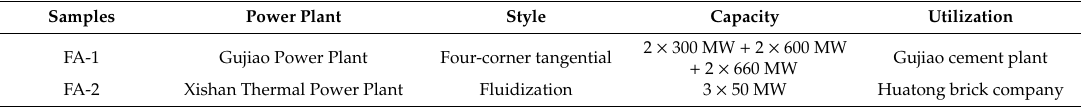
Table 1. Information on the two power plants sampled in this